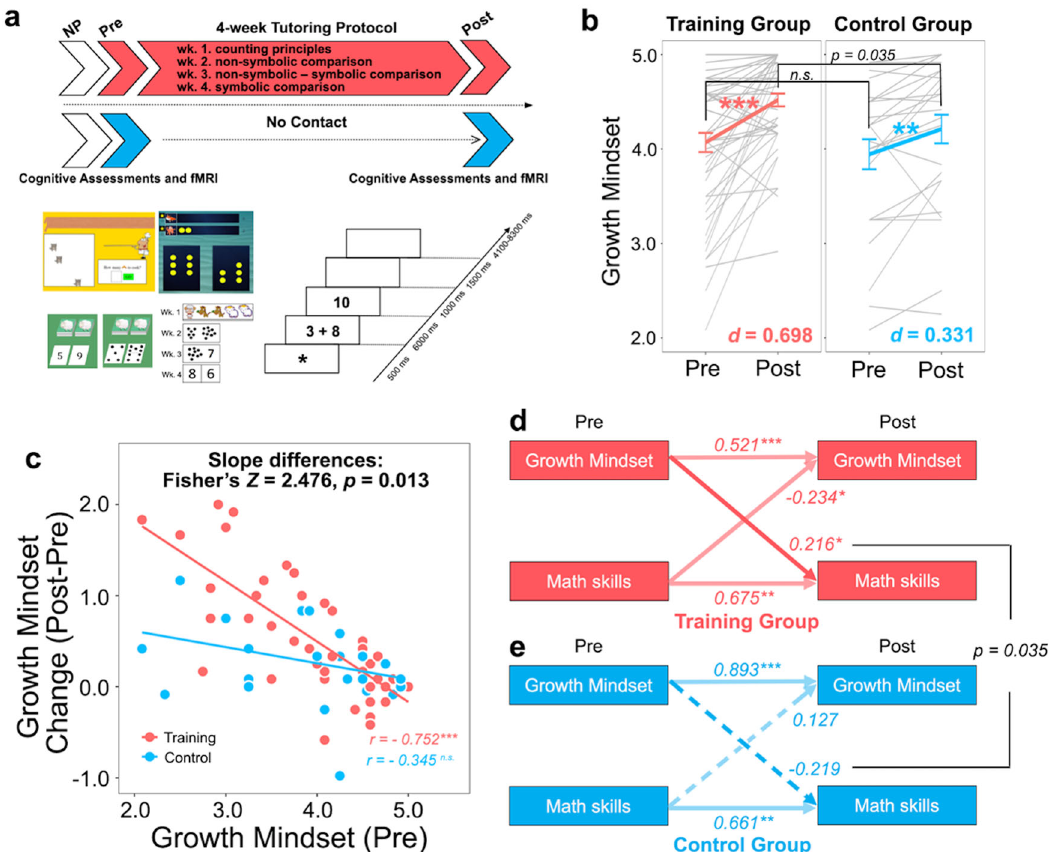
Fig. 1 Overview of study design and training-related changes in growth mindset in children. a The study included multiple visits, with neuropsychological assessments (NP) at the beginning of the study and cognitive assessments and fMRI sessions at pre- (Pre) and post- (Post) visits. Children in the training group participated in a 4-week tutoring-based training program and those in the control group completed all parts of the study except for training. Sample tutoring materials and fMRI task are shown. Additional description of the tutoring protocol and fMRI task design can be found in Methods . Adapted from Chang et al. 29 . b Greater endorsement of growth mindset was observed in the training, compared to control, group at post-visit after the 4-week period. Group means are shown in thicker lines and individual trajectories are shown in thinner gray lines. Error bar shows standard error of mean. c Growth mindset prior to training correlates with changes in growth mindset in the training (red) group, with a signi fi cant difference in slope between training and control (blue) groups. d , e Cross-lagged panel analysis in structural equation modeling (SEM) shows a signi fi cantly greater cross-lagged effect of growth mindset on math skills (WJ-III Math Fluency) in the ( d ) training (solid red line), compared to ( e ) control (dotted blue line), group. Values represent standardized path estimates. * p < .05, ** p < .01, *** p < .001, n.s . not signi fi